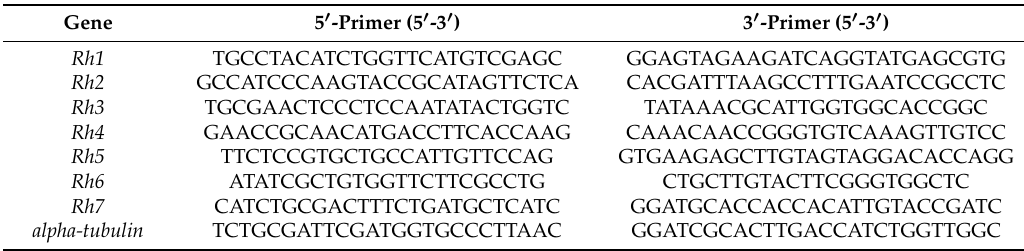
Table 1. Primers used in the